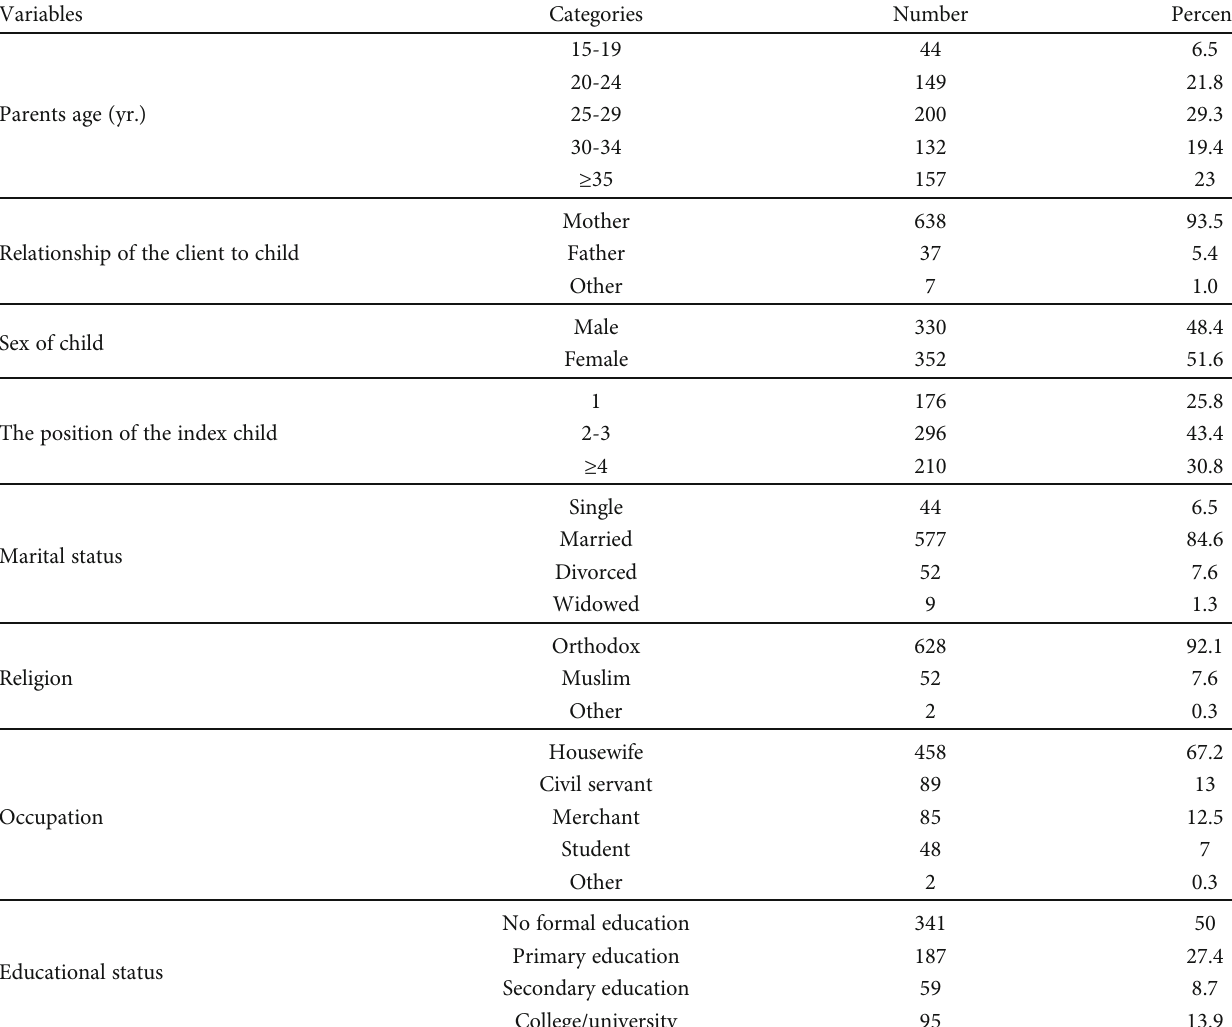
Table 1: Sociodemographic characteristics of mothers receiving immunization service in Wadla district, North Wollo, Amhara regional state, northeast Ethiopia, 2019, n = 682 .